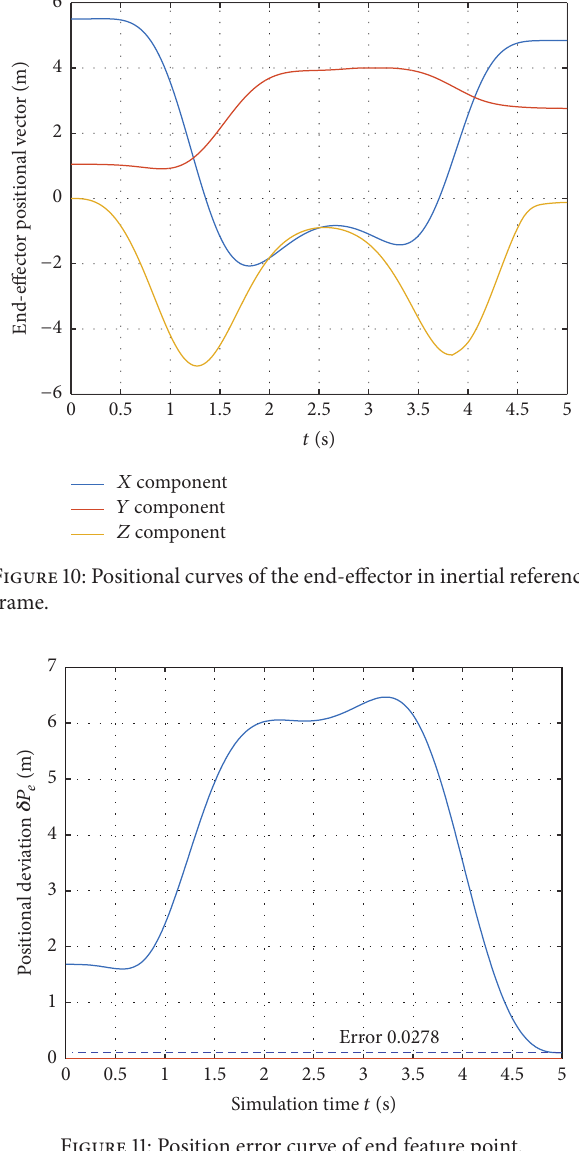
Figure 11: Position error curve of end feature